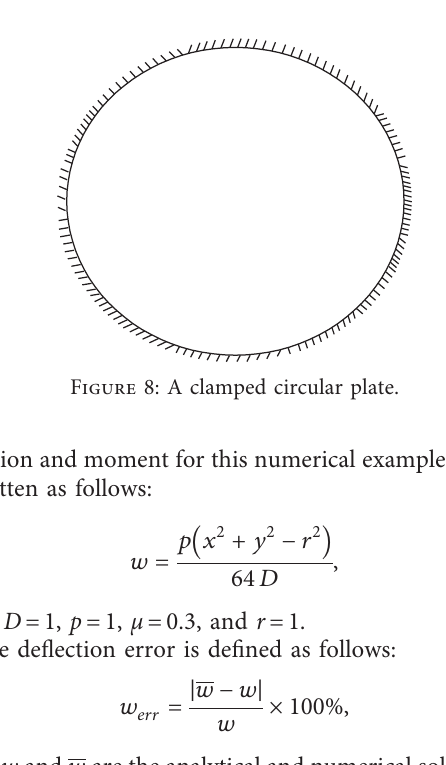
Figure 7: Background integral points and background cells.